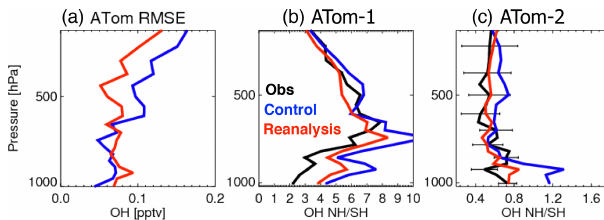
Figure 10. Vertical profiles of (a) OH RMSEs compared with the ATom-1 and ATom-2 aircraft observations (in pptv) and interhemi- spheric gradients of OH for (b) ATom-1 and (c) ATom-2 from the observations (black), control run (blue), and reanalysis